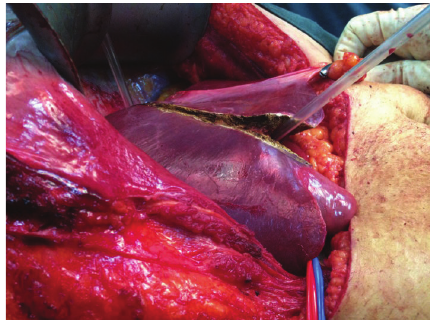
Figure 6: A nasogastric tube is used to execute the hanging maneuver to facilitate anterior parenchymal transection right down on to the IVC at the junction between RHV and MHV identified to be tumour-free on intraoperative